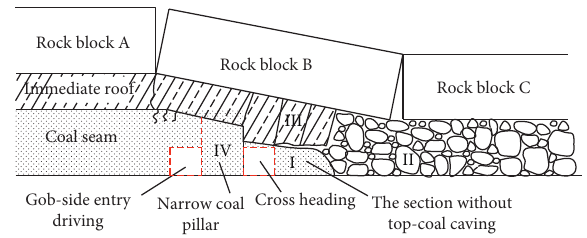
Figure 1: Surrounding rock structural mechanics model during gob-side entry in a fully-mechanized top-coal caving face.